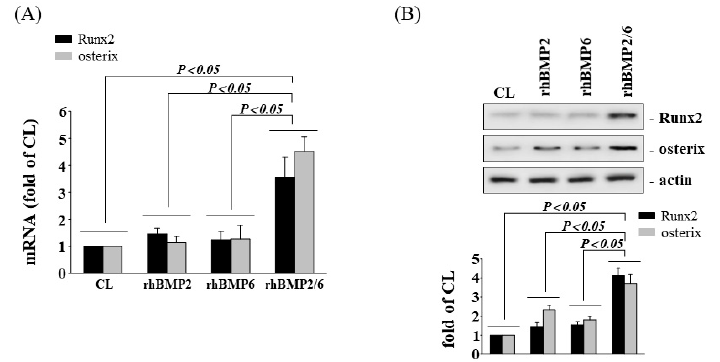
Figure 4. Recombinant human (rh)BMP-2/6 heterodimer upregulates osteogenic gene expression. AF cells were kept as controls (CL) or treated with recombinant proteins of BMP-2, BMP-6, or BMP- 2/6 heterodimer for 8 h, and the gene expressions of Runx2 and osterix ( A ) were measured by real- time PCR analysis. The Runx2 and osterix protein expressions were examined by Western blotting ( B ). The results are mean ± SD and are representative of three independent experiments (n = 3). Data statistics were completed with ANOVA followed by Scheffe’s test. The results were considered sig- nificant for p <